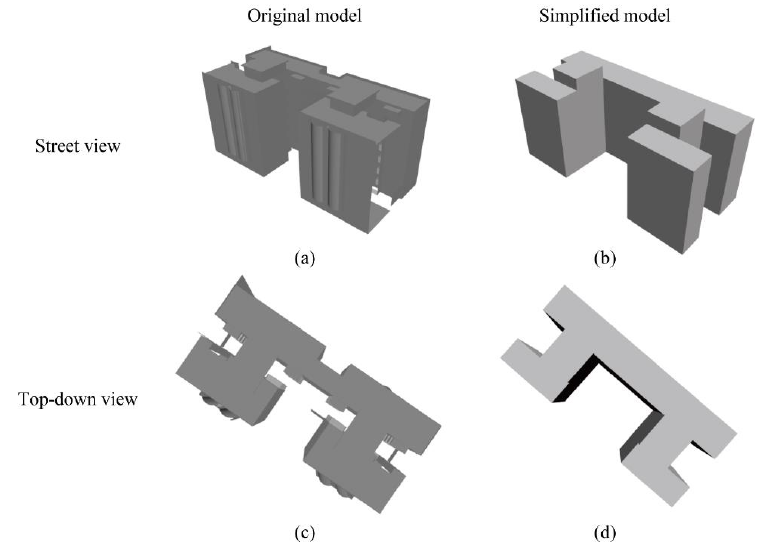
Figure 9. Simplification of a 3D building with flat roofs: (a) original model in street view; (b) simplified model in street view; (c) original model in top-down view; and (d) simplified model in top-down view.